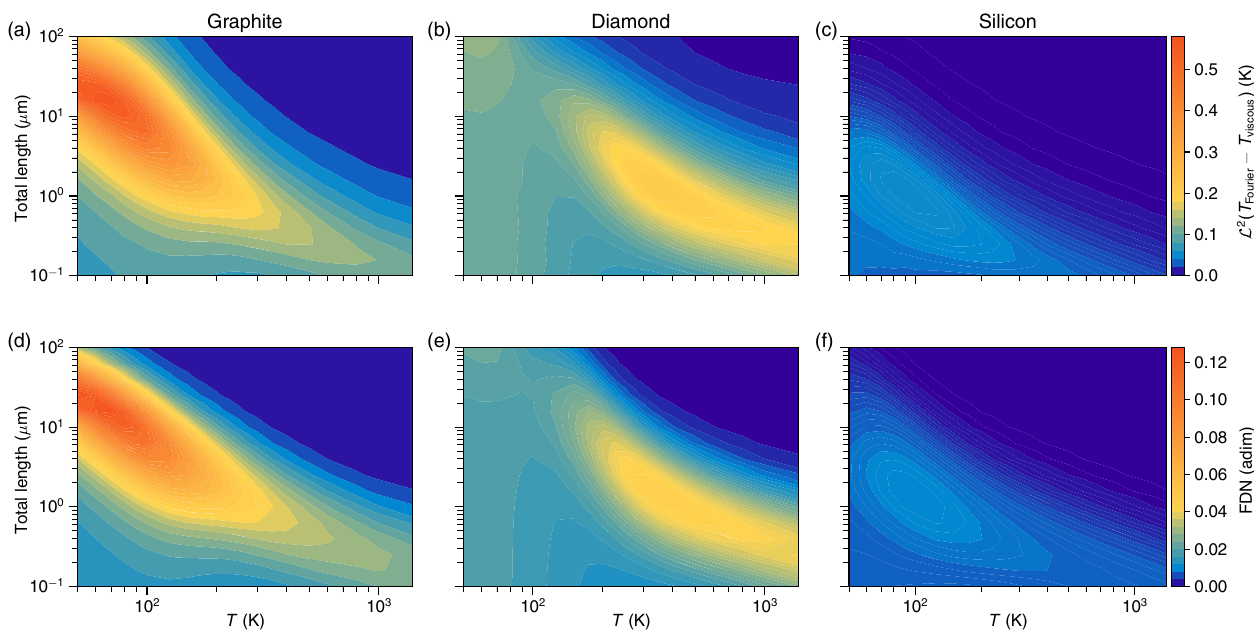
FIG. 5. Top row: L 2 distance (see text) between the temperature profile predicted by Fourier ’ s law and that of the viscous heat equations (10) and (11), shown as a function of temperature and total length of a sample similar (in the geometric sense) to the shape of Fig. 3 for the cases of graphite (a), diamond (b), and silicon (c). The color quantifies the L 2 distance between the temperature profiles x; y Þ ] and the viscous heat equations (10) and (11) [ T x; y Þ ], computed over the region G predicted by Fourier ’ s law [ T Fourier ð viscous ð l corresponding to points with x > 1 , where l is the total length of the sample geometrically similar to that in Fig. 3 (see main text 5 TOT TOT for details). Bottom row: Fourier deviation number [(FDN), as defined in Eq. (22)] for the same materials as a function of temperature and total length of the sample (for the geometry of Fig. 3, the characteristic size L appearing in FDN is the shortest length scale, i.e., 1 = 5 of the total length l ). It is apparent that the FDN correctly identifies the deviations between the solutions of Fourier ’ s equation and the TOT viscous heat